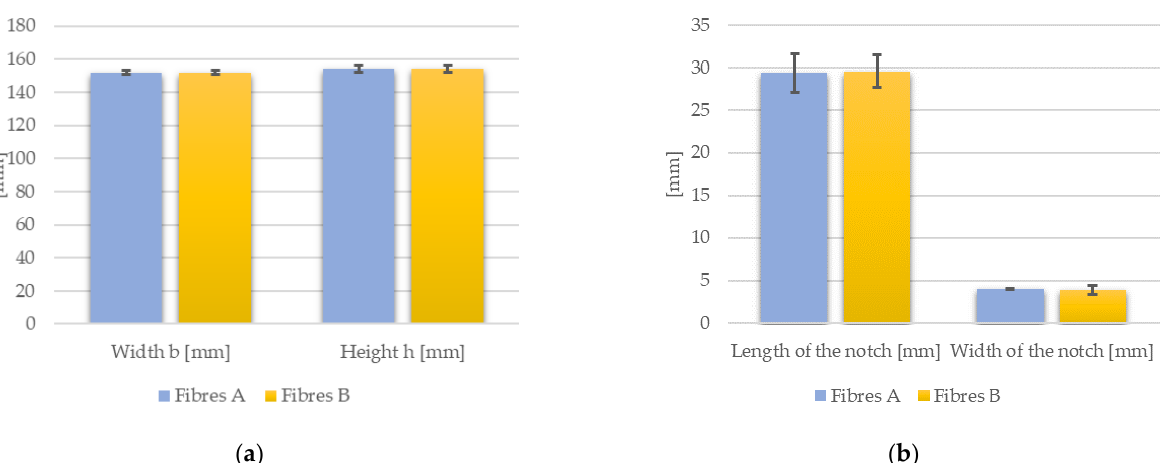
Figure 2. Average and standard deviation of width b (mm) and height h (mm) of samples ( a ), av- erage and standard deviation of length (mm) and width of the notch (mm) ( b ).